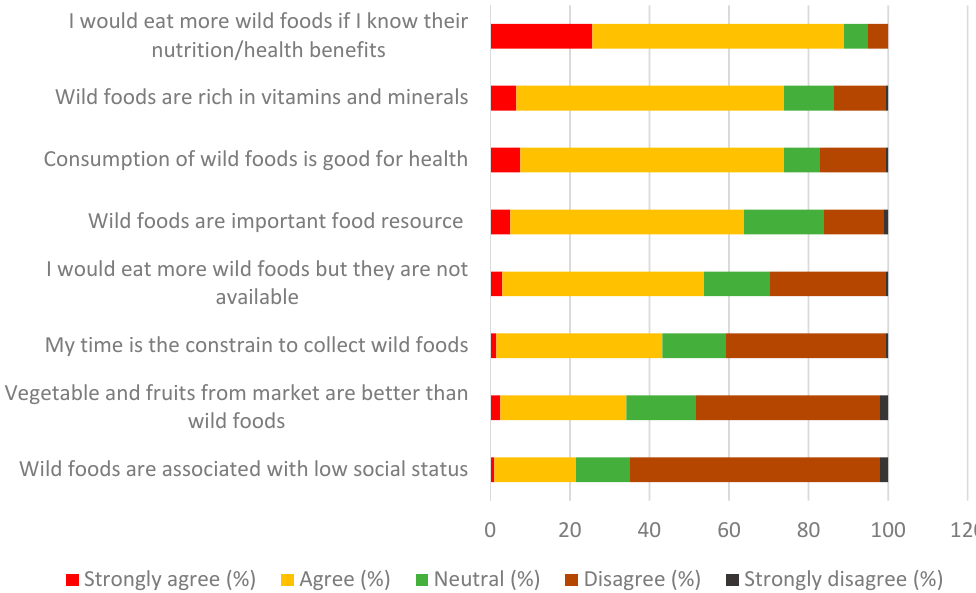
Figure 6. Attitudes of women towards consuming wild food plants.